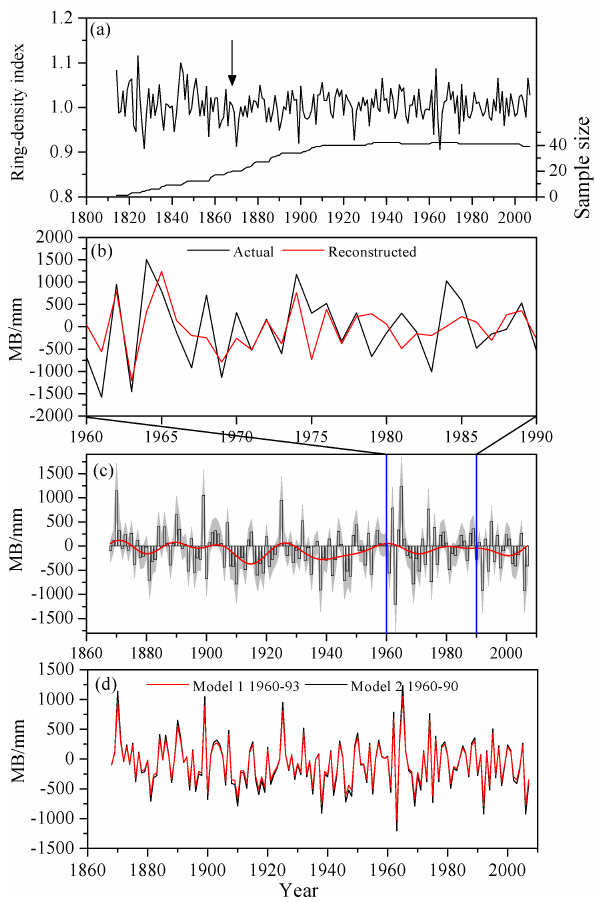
Fig. 2. (a) MLD residual chronology of Abies fabri and the sam- ple size. Arrow denotes the year with EPS > 0 . 85. (b) Comparison of actual and reconstructed MB at the Hailuogou Glacier in the pe- riod 1960–1990. (c) Reconstructed MB variability at the Hailuogou Glacier back to 1868 (black column) and its 95% confidence in- terval (gray shade). Red line represents the 10yr FFT (fast Fourier transform) smoothing curve. (d) Comparison of the reconstructions based on the two regression models (Model 1, period 1960–1993; Model 2, 1960–1990) over the period